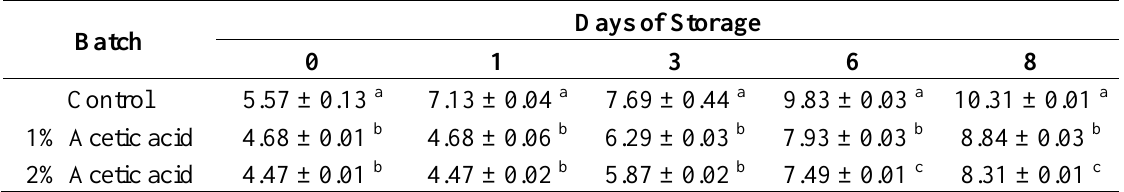
Table 1. The effect of acetic acid on mesophile counts on poultry legs (log CFU/g). Batch